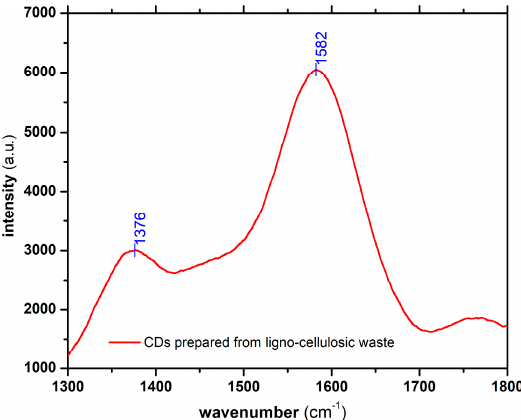
Figure 4. Recorded Raman spectrum for the prepared CDs. The peak located at 1582 cm − 1 (G band) corresponds to the in-plane stretching vibra- tion in the E 2g mode of the graphitic structures, being due to sp 2 carbon atoms. The peak located at 1376 cm − 1 (D band) is specific to the swinging bond vibrations of the carbon atoms located at the periphery of the plane in the disordered graphitic structures, being an indicator of the structural defects. The intensity ratio of these two ID/IG peaks is pro- portional to the disorder degree or structural defects located in the graphitic structure, also indicating the ratio between sp 3 /sp 2 carbon atoms [42]. In the case of CDs prepared from ligno-cellulosic waste, the ID/IG ratio was approx. 1/3, which suggests a relatively ordered graphitic structure. The structural defects most likely occurred due to the inter- calation of various atomic species (e.g., oxygen) in the graphitic structure or the existence of certain functional groups attached to the terminal carbon atoms in the graphitic net- work. The recorded results are in agreement with those acquired through FT-IR investi- gation, which highlighted the existence of various functional groups within the structure of the CDs. 3.5. XRD Analysis Figure 5 presents the XRD pattern recorded for the prepared CDs. The broad peak located at 28.51° 2 θ is typical for graphitic structures [43]. The peak is slightly up-shifted compared with plain graphite peak (26.4° 2 θ ) corresponding to a minor decrease of the plane spacing between the carbon layers from 3.37 Å to 3.12 Å most probably due to the presence of various atomic species inserted within the graphitic structure as was also sug- gested by the Raman investigation results. The presence of the narrow peaks located at 39.49 and 45.71° 2 θ are a result of the metallic residues (Section 3.1, EDX Investigation) inherently trapped within the graphitic core.